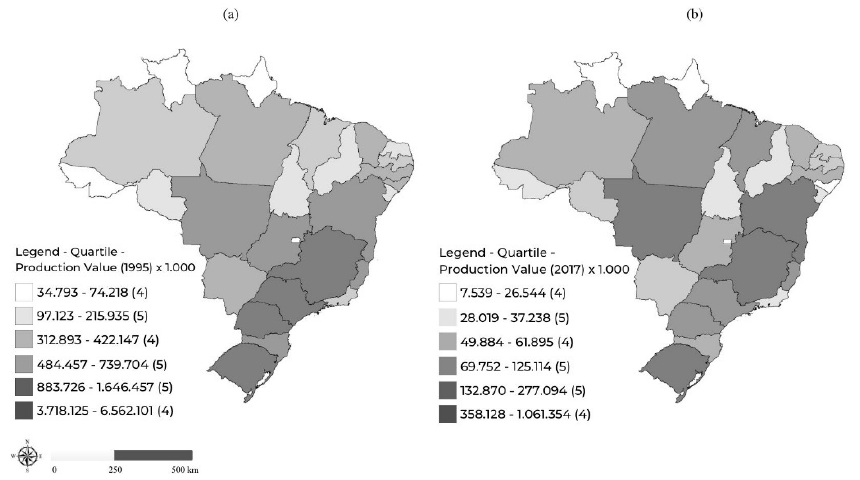
Figure 1. Value of Brazilian agricultural production in 1995 ( a ) and 2017 ( b ), in current USD. Source: Elaborated by authors based on [20,21].